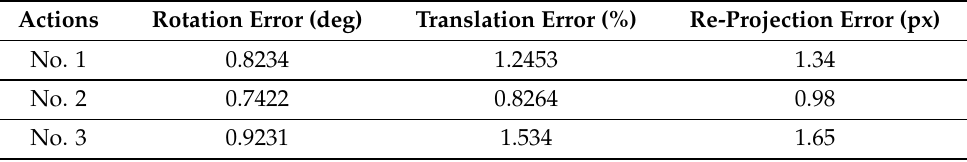
Figure 6. The images samples captured for chessboard calibration. More than 50 pairs of images are captured to guarantee the accuracy of the calibration results. Table 1. Self-calibration results compared with the chessboard calibration. The re-projection error is computed by projecting the 3D position of the chessboard corners with the proposed calibration